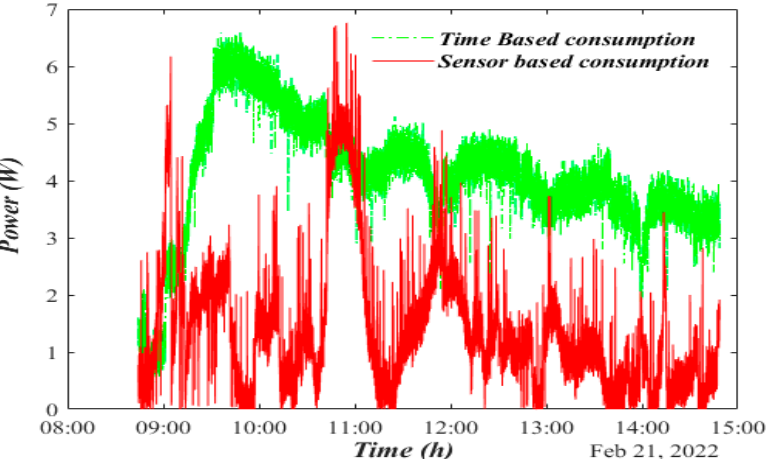
Figure 10. Power consumption of the sensor-based system and the azimuth-based system. In contrast, the minimum power consumption was 0.13 W at 8:52 a.m. As for the sensor-based system, the maximum power consumption was 6.0 W at 9:05 a.m. On the other hand, the minimum power consumption was 0.04 W at 2:35 p.m. The leading differ- ence between the systems’ power consumption was 6.5 W which was recorded at 9:48 a.m., where the azimuth-based system had higher consumption. The mean power con- sumption of the sensor-based system and the azimuth-based systems were 1.4 W and 4.1 W, respectively, whereas the azimuth-based system had a higher power consumption of 192%. 4.4. Energy Analysis Figure 11 represents the net power comparison of the azimuth-based system and sen- sor-based and system during day hours. Figure 11. Net power comparison of the azimuth-based system and the sensor-based system. The net power production of the sensor-based tracking system and the azimuth- based tracking system was calculated by subtracting the power generation from the power consumption. The results show that the sensor-based PV system’s module has a higher net power generation than the azimuth-based PV system. The maximum net power generation of the sensor-based system was 56.9 W at 12:20 p.m. In contrast, the minimum